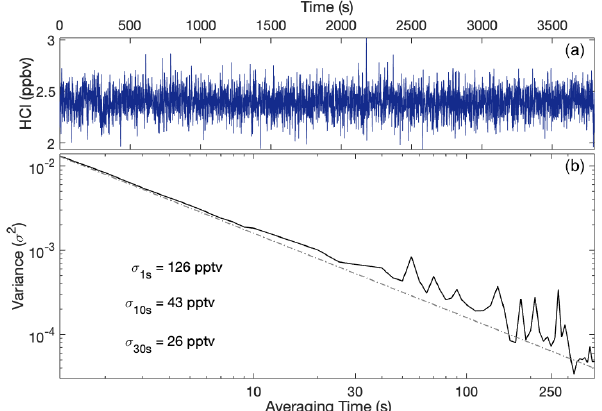
Figure 7. Allan variance plot of the HCl instrument after ∼ 1h of constant flow of diluted HCl. Panel (a) shows the mixing ratio of HCl over time. Panel (b) shows the variance as a function of aver- aging time (solid black line) along the theoretical white noise limit (dashed black line), where averaging times up to 7min are